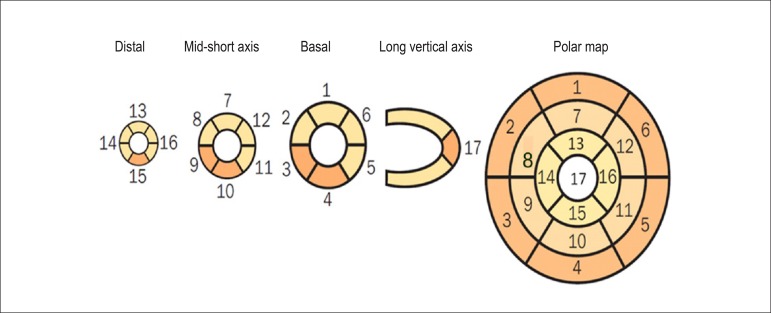
Numerical segmentation model of the left ventricular myocardium in 17 parts, considering tomographic slices of the minor and long vertical axes (distal or apical, middle, and basal or proximal portions), representing the myocardial regions; furthermore, correspondence of segments may be seen as presented in the polar map, which represents radiopharmaceutical distribution throughout the left ventricular myocardium in the form of a polar map, whose center corresponds to the apex and whose peripheries correspond to the basal portions. The correspondence between the numerical classifications and their respective segments is described in Table 18.